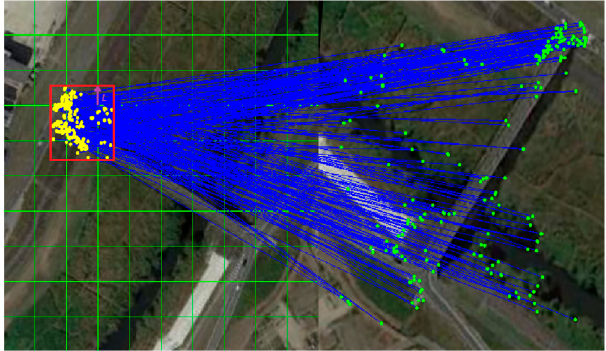
Figure 7. Schematic diagram of grid expansion.